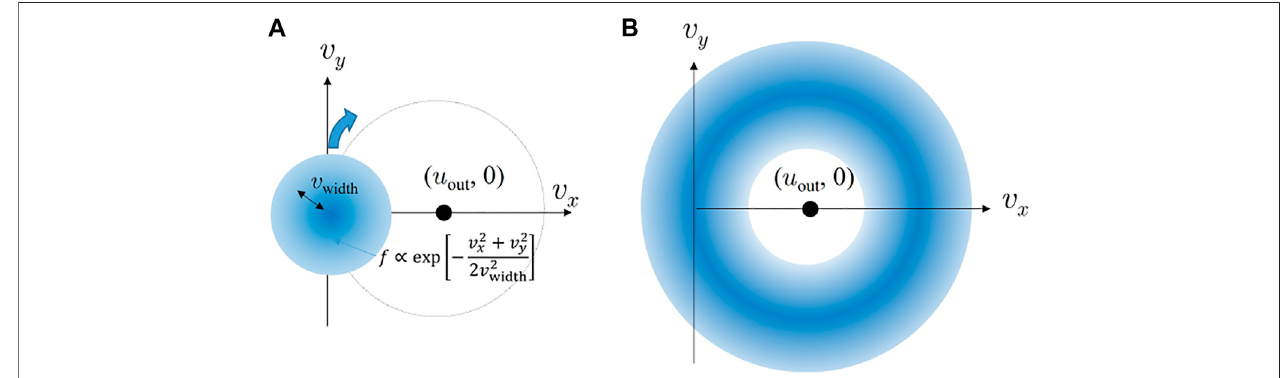
FIGURE 3 | Schematic diagrams showing that (A) : an initial Maxwellian distribution begins to rotate around the center ( u out , 0) and that (B) : a ring-shaped distribution with a width is newly created as a result of the rotation of the initial Maxwellian distribution.